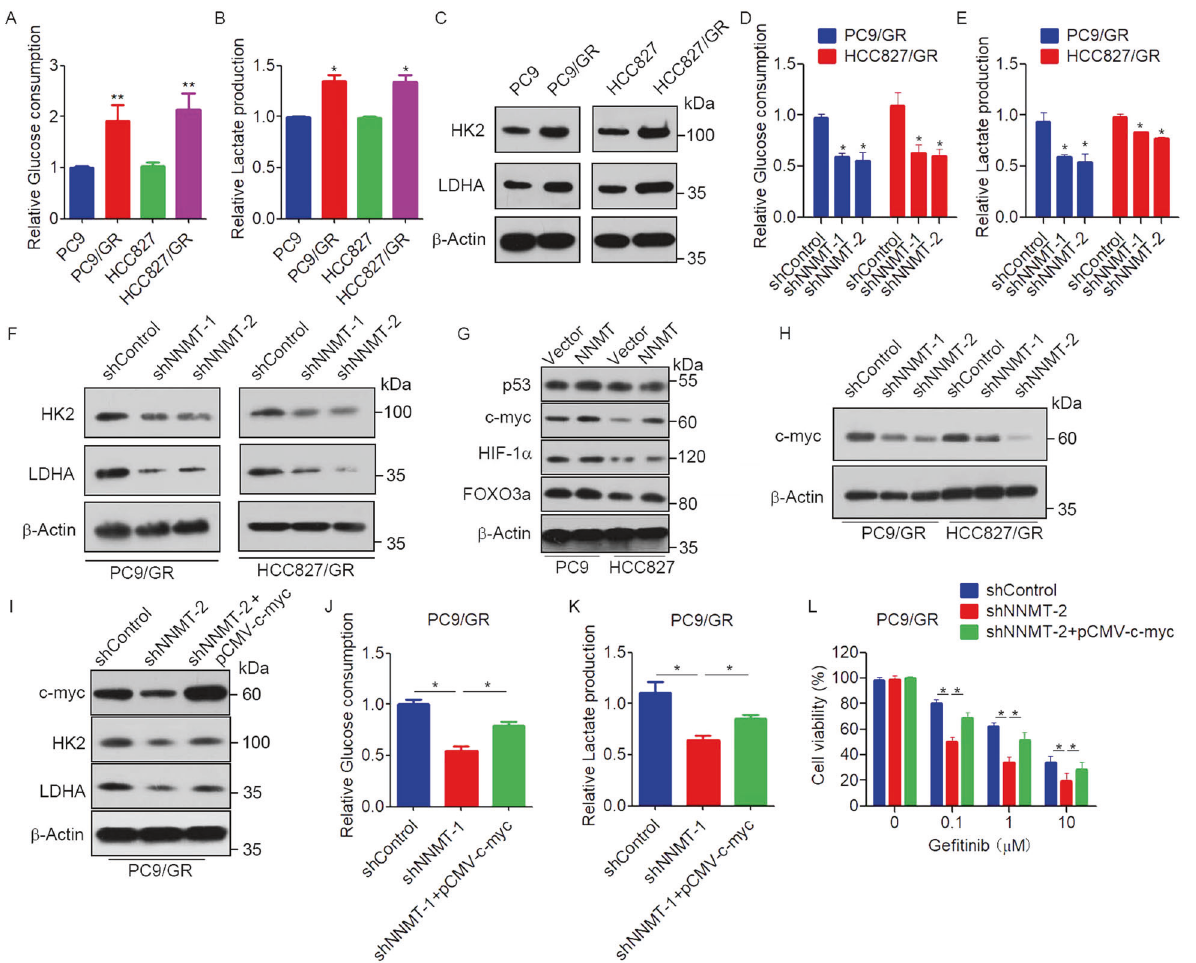
Fig. 4 NNMT enhances glycolysis to promote EGFR-TKIs resistance in NSCLC cells. A , B Glucose uptake and Lactate secretion levels in PC9/ GR, HCC827/GR, PC9, and HCC827 cells were measured. C The expression of HK2 and LDHA in PC9/GR, HCC827/GR, PC9, and HCC827 cells were measured by Western blot. D , E Glucose uptake and Lactate secretion levels in PC9/GR or HCC827/GR cells were stably transfected with NNMT shRNA or control shRNA. F PC9/GR or HCC827/GR cells were transfected with NNMT shRNA or control shRNA, the expression of HK2 and LDHA were measured by Western blot. G PC9 and HCC827 cells were stably transfected with NNMT-overexpressing vector, the expression of p53, c-myc, Hif-1 α , FOXO3a, and β -actin were measured by Western blot. H PC9/GR or HCC827/GR cells were transfected with NNMT shRNA or control shRNA, the expression of HK2 and LDEA in were measured by Western blot. I PC9/GR cells were co-transfected with NNMT shRNA or control shRNA and pCMV-c-myc, the protein levels of c-myc, HK2, LDHA, and β -Actin were measured by western blot. J , K Glucose uptake and Lactate secretion levels in PC9/GR cells co-transfected with NNMT shRNA or control shRNA and pCMV-c-myc. L PC9/GR cells co-transfected with NNMT shRNA or control shRNA and pCMV-c-myc were treated with ge fi tinib at the indicated concentration for 72 h, cell viability was evaluated by MTS assay. Each point represents the mean ± SD. Data show a representative of three independent experiments. (* p < 0.05, ** p <